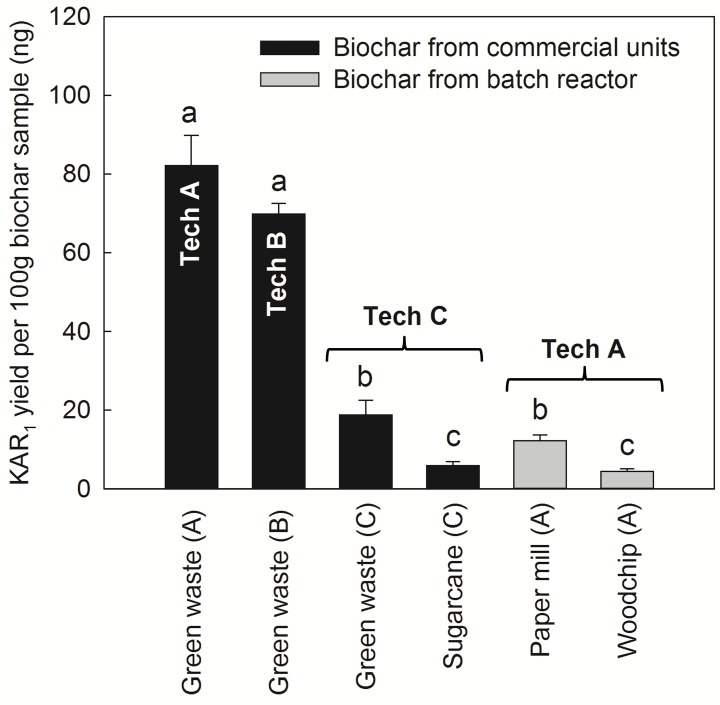
The yield of karrikinolide (KAR1) isolated from study biochars as related to pyrolysis conditions and input feedstocks.Biochars were made by Technologies A, B or C in commercial units from a green waste or sugarcane trash feedstock or by a 20 L sized batch reactor using a paper mill waste or woodchip feedstock. KAR1 yield is represented as mean ± SEM in each study biochar (ng KAR1 per 100 g of biochar, n = 3 replicates). Analysis of variance compared KAR1 abundance within different biochars (F5,11 = 79.51, P < 0.001; data log10 transformed prior to analysis); values with different letters are significantly different from one another (Tukey test, α = 0.05).